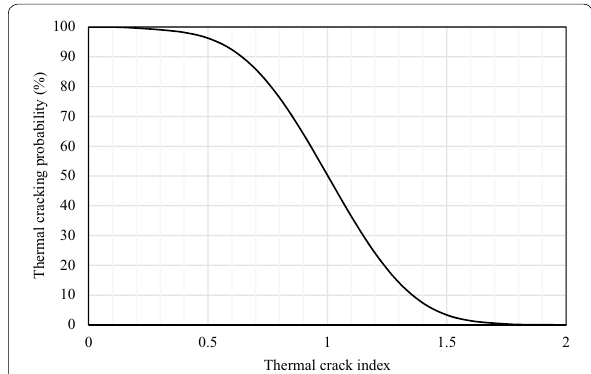
Fig. 9 Relationship probability of crack growth and crack index.